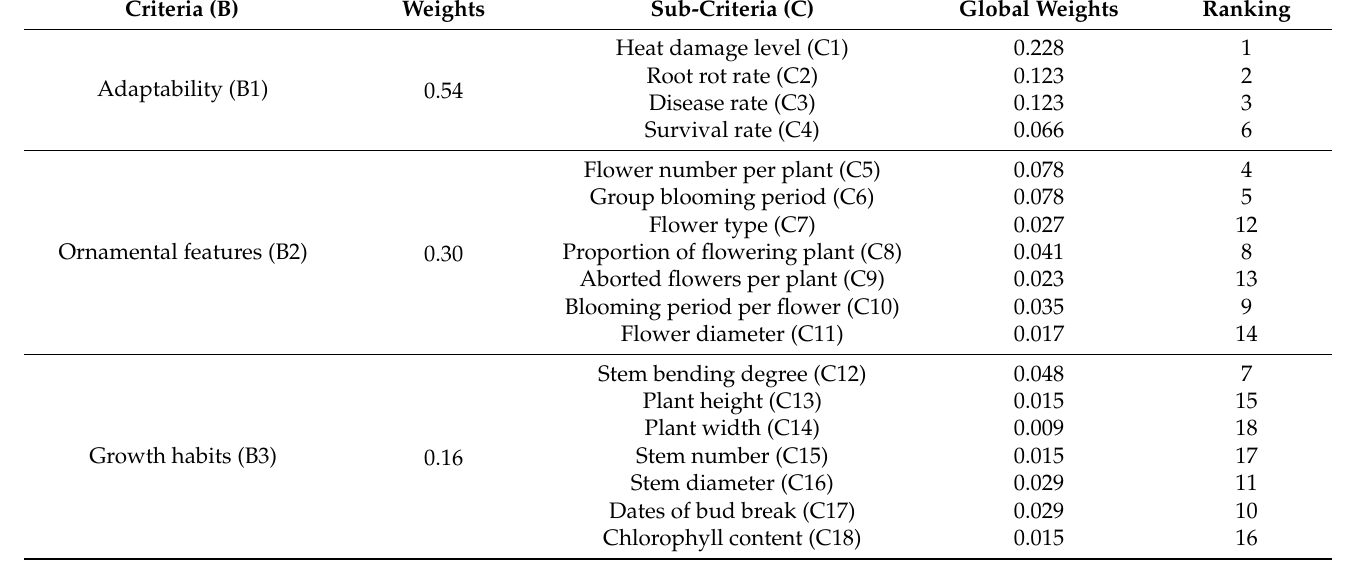
Table 2. Global weights of the three criteria and eighteen